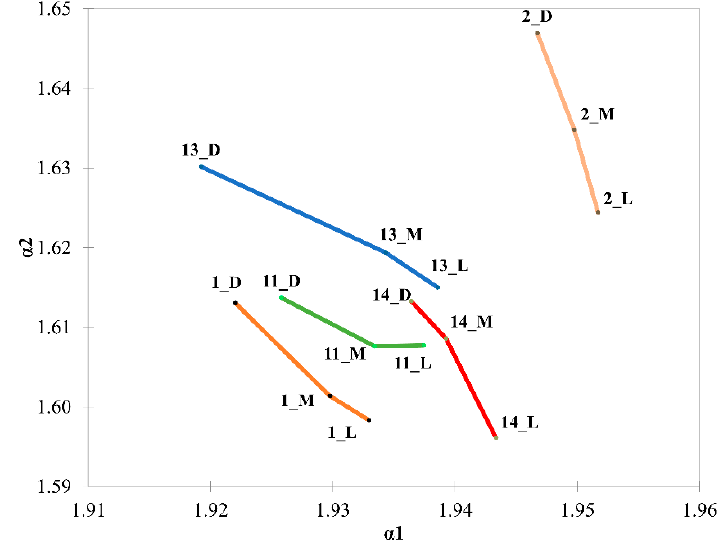
Figure 5. α 1 and α 2 coefficients obtained from detrended fluctuation analysis. Averaged spectra of the green, light, medium and dark roast samples. Different colors denote different coffee origins.